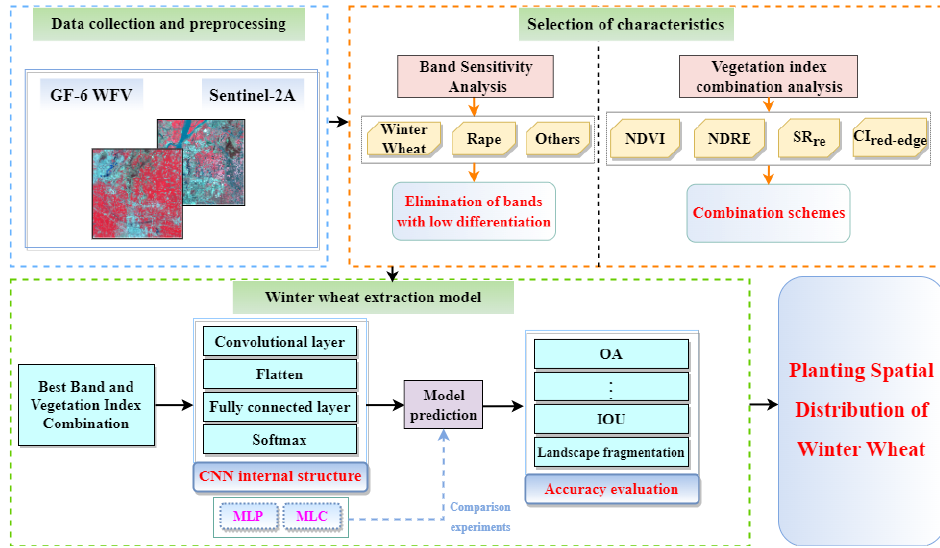
Figure 5. Flowchart overview of winter wheat extraction method.